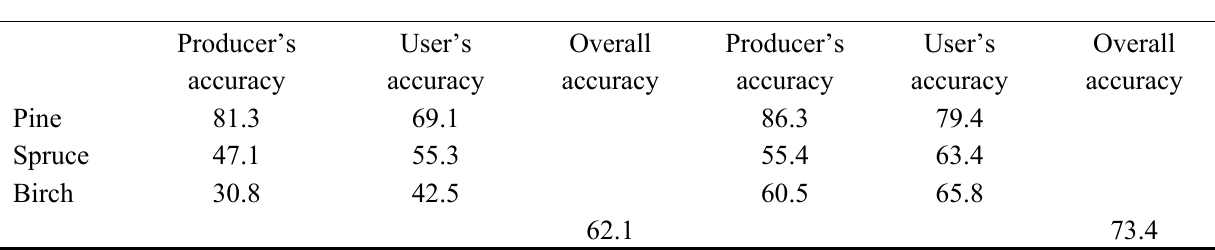
Table 5. Three accuracy measures for the classifications using DSC features and together with FWF